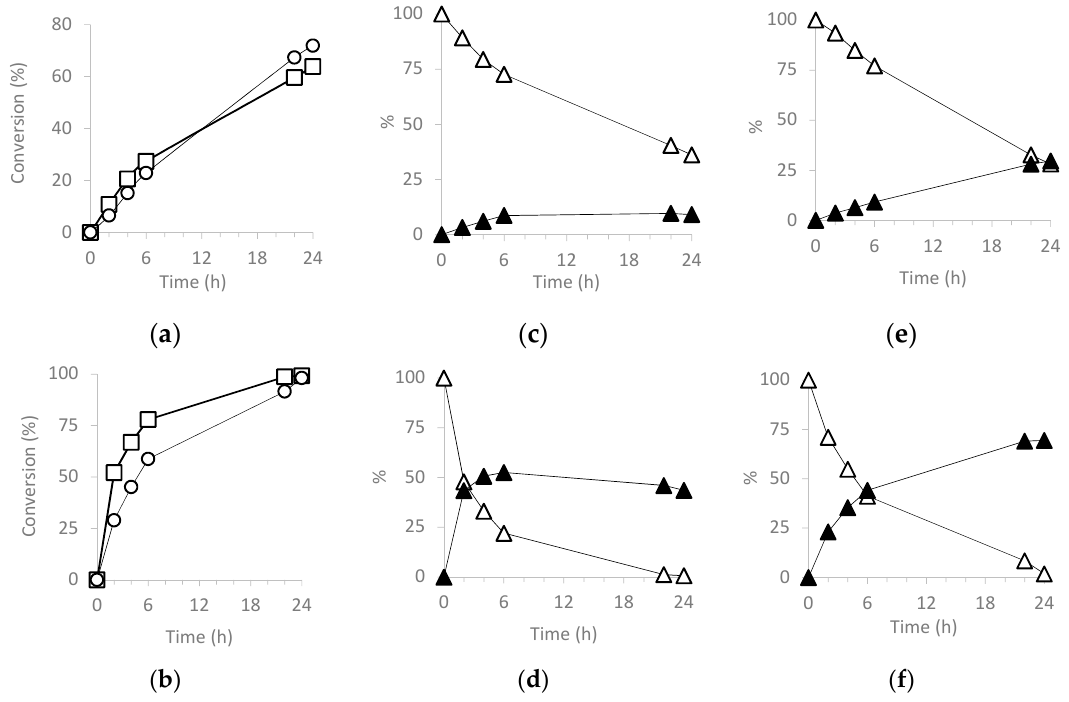
Figure6. ComparisonofCOconversionbetween( a )H 3 PW 12 O 40 ( (cid:3) )andSiO 2 @PW( Figure 6. Comparison of CO conversion between ( a ) H 3 PW 12 O 40 ( □ ) and SiO 2 @PW (  ), ( b ) H 3 PMo 12 O 40 ( (cid:3) ) and SiO 2 @PMo ( ). Evolution of CO ( (cid:52) ) and COE ( (cid:78) ) with ( c ) H 3 PW 12 O 40 , ( d ) H 3 PMo 12 O 40 , ( e ( □ ) and SiO 2 @PMo (  ). Evolution of CO (  ) and COE (  ) with ( c ) H 3 PW 12 O 40 , ( d ) H 3 PMo 12 O 40 , ( e ) (cid:35)